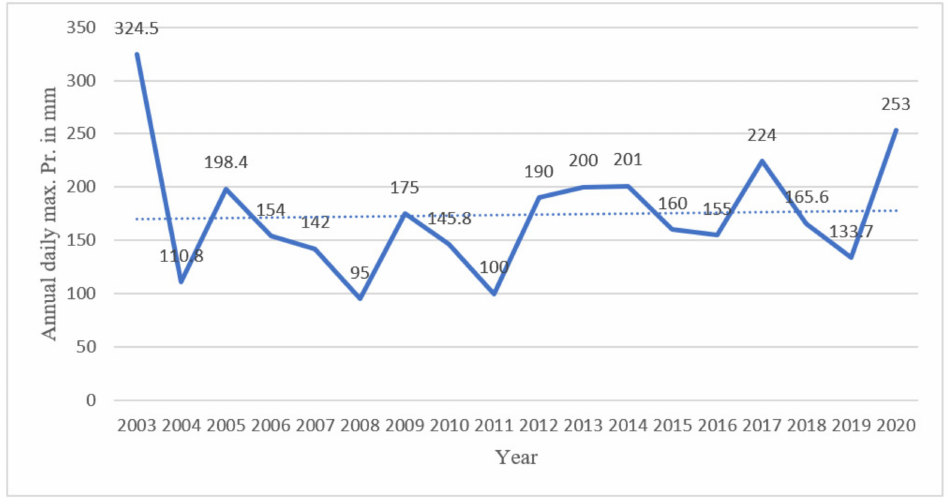
Figure A4. Observed annual daily maximum precipitation of Dumkauli, Nawalpur.